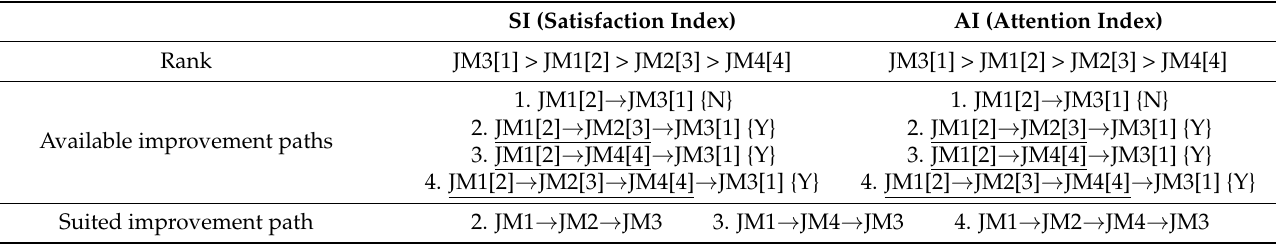
Table 17. The suited improvement paths of the joint information and decision making (JM)